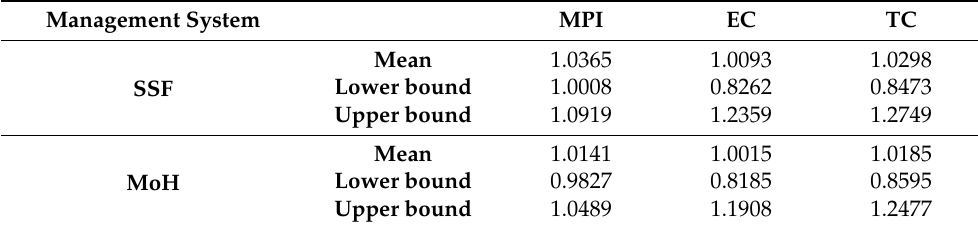
Table 7. Mean 95% confidence intervals for MI, EC, and TC by type of